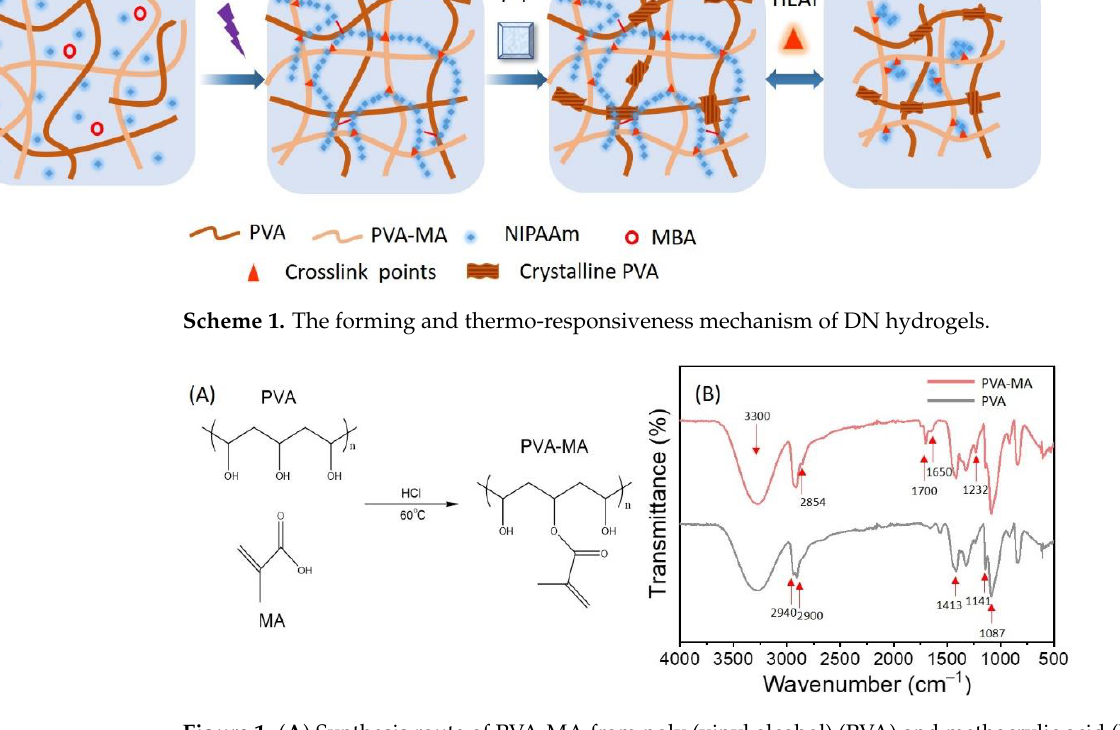
Figure 1. ( A ) Synthesis route of PVA-MA from poly (vinyl alcohol) (PVA) and methacrylic acid (MA). ( B ) FT-IR spectra.